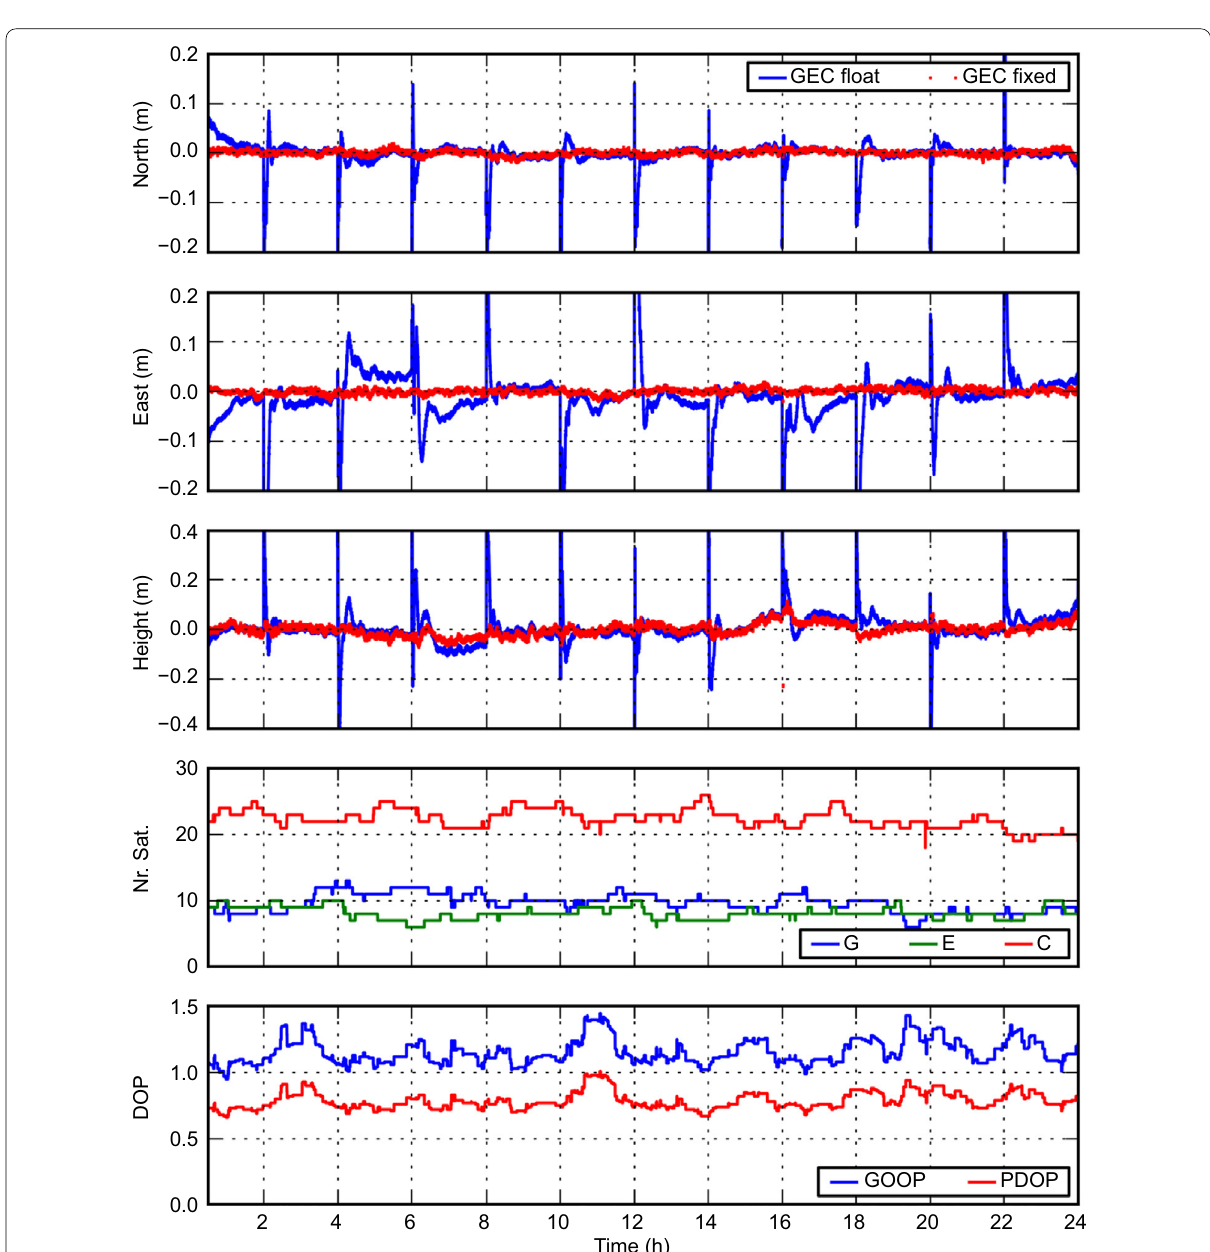
Fig. 9 Time series of GPS/Galileo/BeiDou combination PPP (blue line) and PPP-IAR (red dot) solutions with resets of every two hours for Site 4843, respectively for North (top row), East (the second row) and Height (middle row) components. The number of used satellites (the fourth row) and their GDOP/PDOP values (bottom row) are displayed as